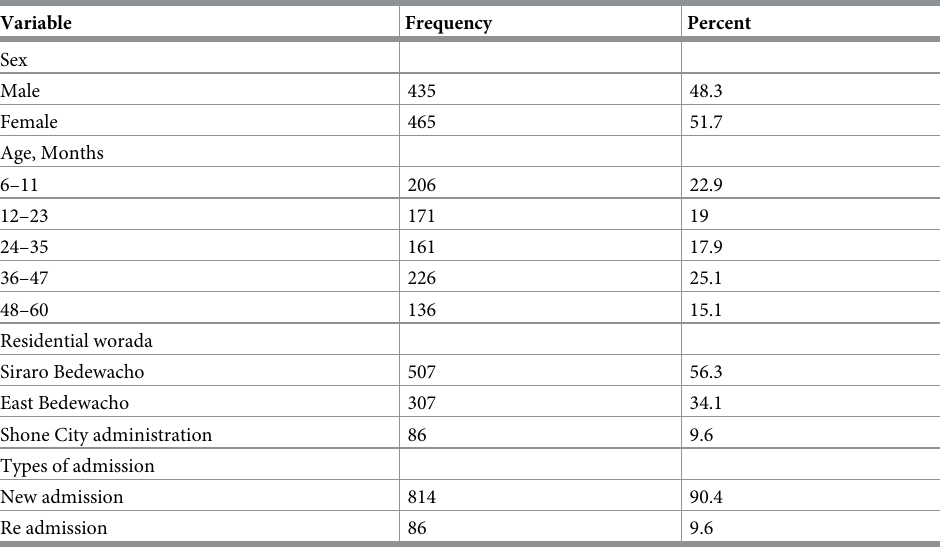
Table 1. Socio demographic characteristic of under five children who are admitted for severe acute under nutri- tion in Hadiya Zone, SNNPR, Ethiopia in the las five years from 2014/2015-2019/2020 (n = 900).